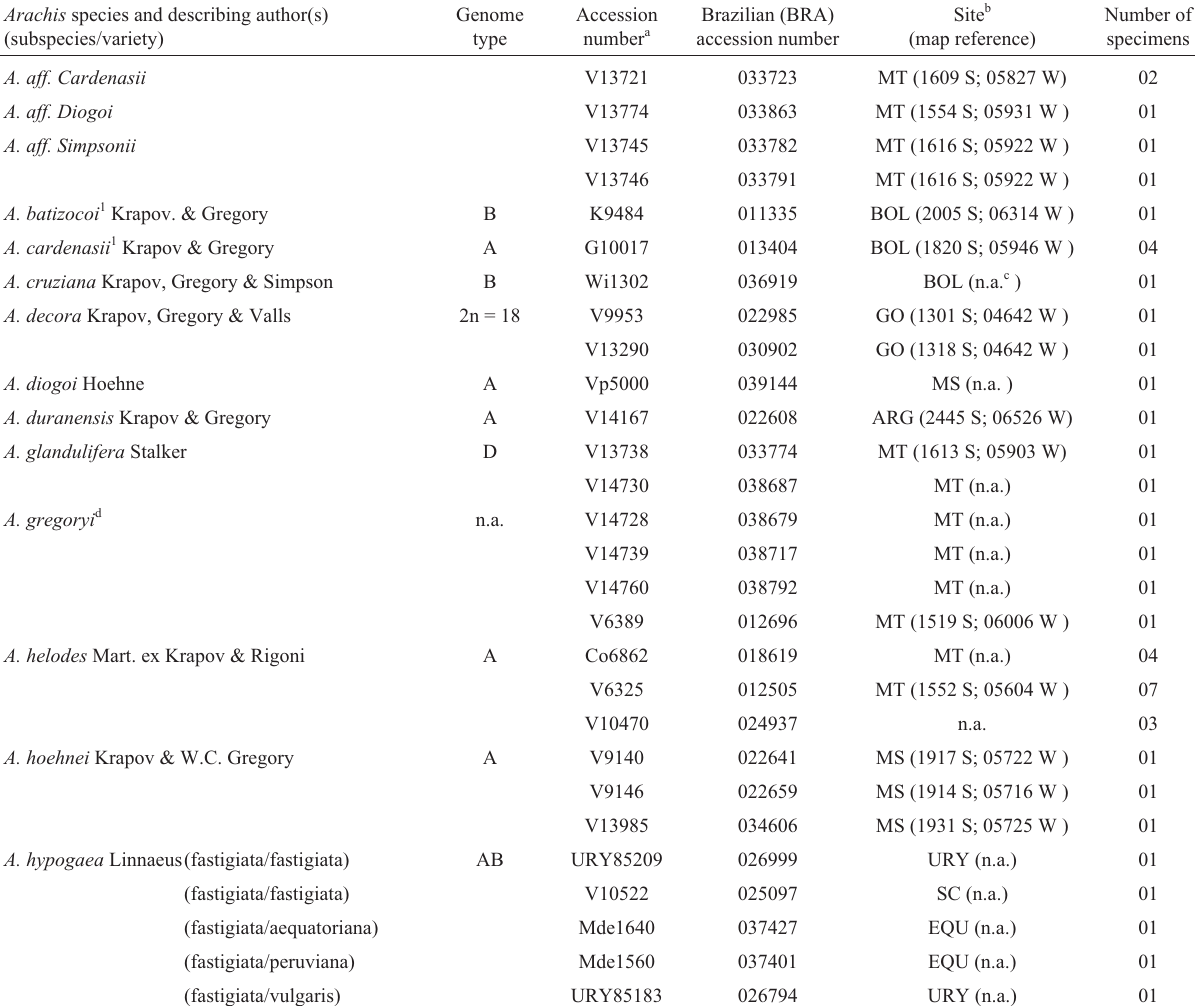
Table 1 - The Arachis section accessions analyzed. Arachis species and describing author(s)